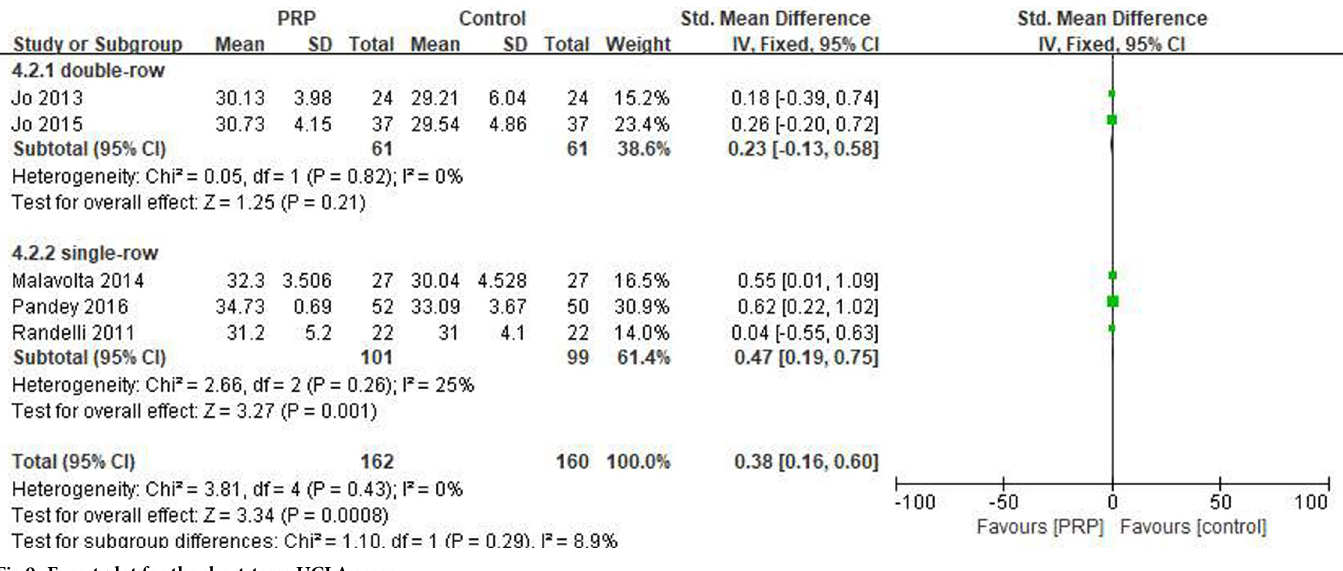
Fig 9. Forest plot for the short-term UCLA